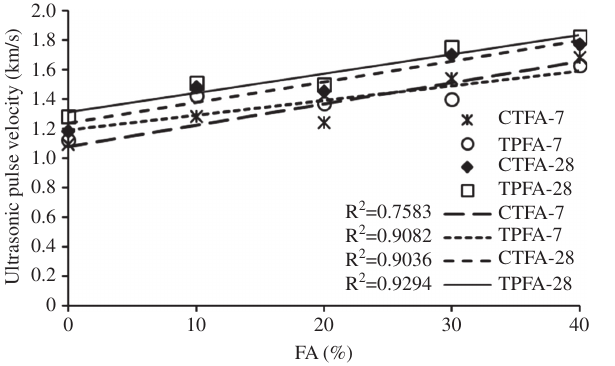
Figure 6 Compressive strength of specimens exposed to